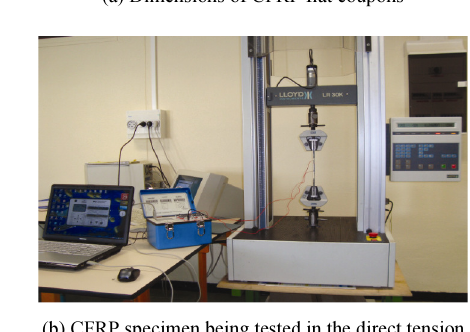
Fig. 3. Flat coupon tensile